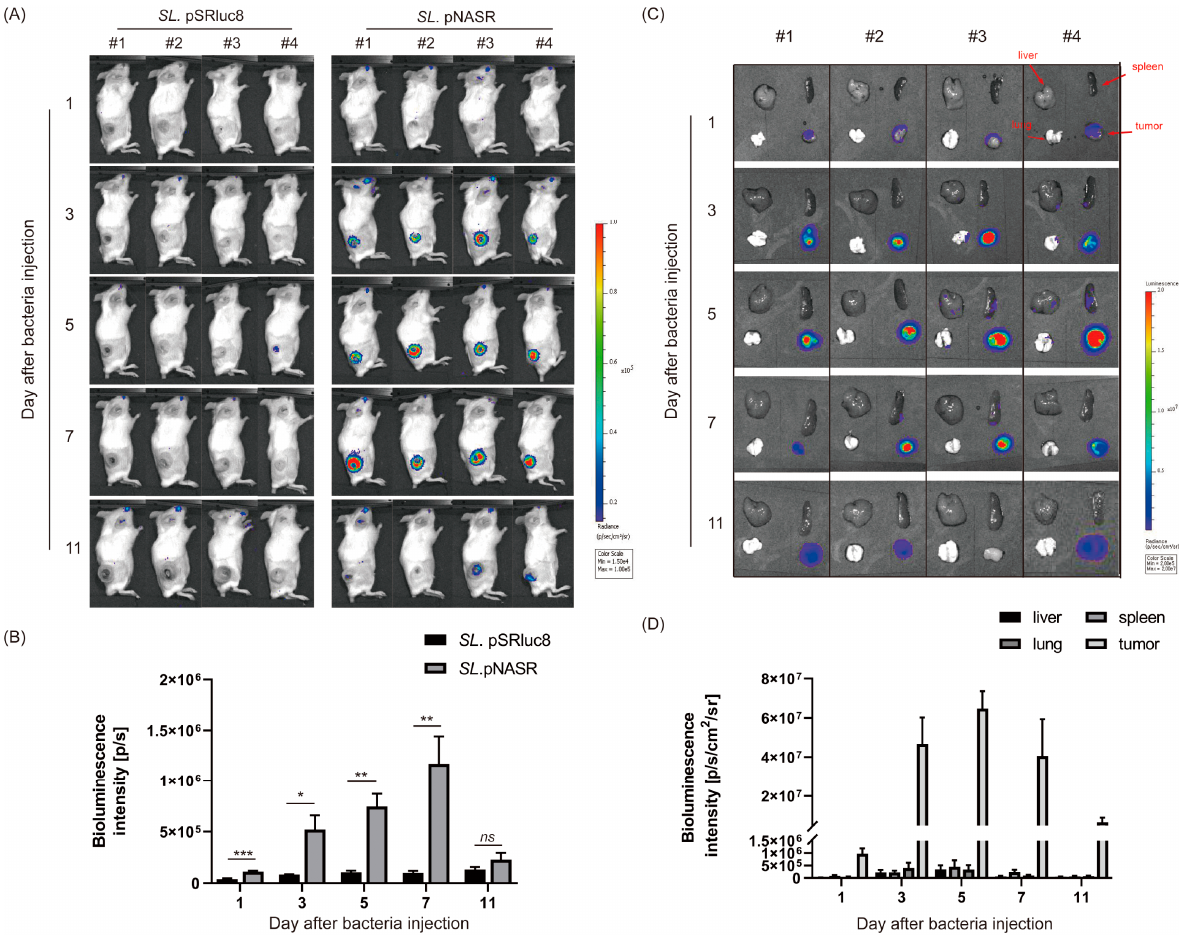
Figure 6. In vivo Rluc8 expression and distribution. ( A ) Bioluminescence images of CT26 tumor- bearing mice 1, 3, 5, 7, and 11 days after injection of 1 × 10 7 CFUs SL . pNASR and SL . pSRluc8. ( B ) Quantification of the intensity of bioluminescence signals from the tumor sites. ( C ) Ex vivo bioluminescence images of Rluc8 expression in normal organs (liver, spleen, and lung) and tumor tissues 1, 3, 5, 7, and 11 days after injection of 1 × 10 7 CFUs SL . pNASR. ( D ) Quantification of the intensity of Rluc8 from ( C ). Error bars represent the mean ± SEM ( n = 4). * p < 0.05, ** p < 0.01, and *** p < 0.001; ns, not significant by Student’s t -tests.